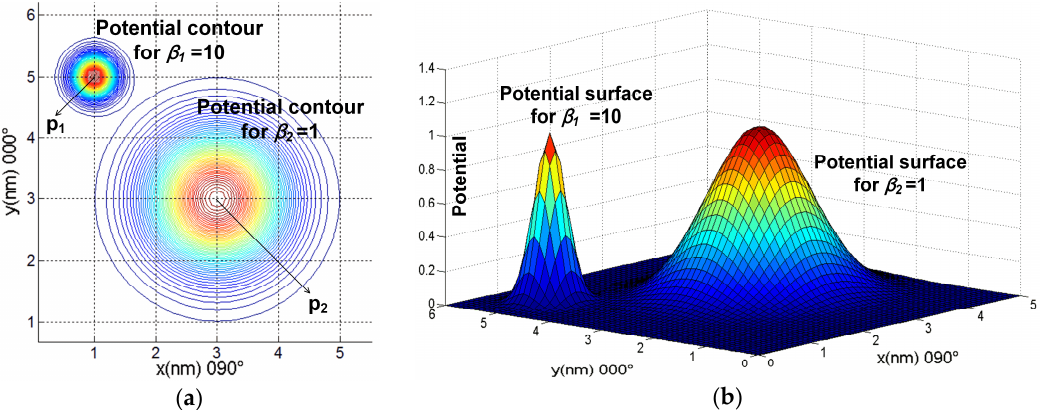
Figure 1. ( a ) The potential contours of the total potential field for two point obstacles with different values of parameter β . ( b ) The corresponding potential surface of the total potential field.